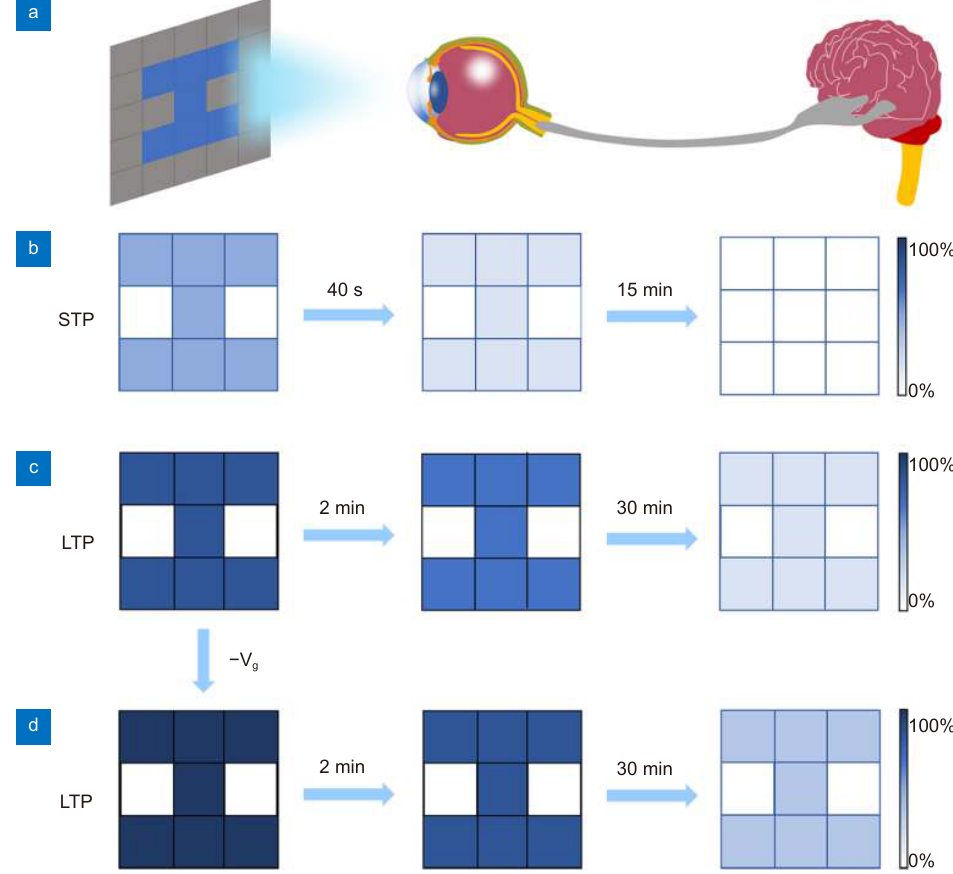
Fig. 6 | Neuromorphic imaging simulation. ( a ) Illustration of neuromorphic letter recognition. The stimulated letter recognition under STP ( b ), LTP with ( c ) or without ( d ) - V g